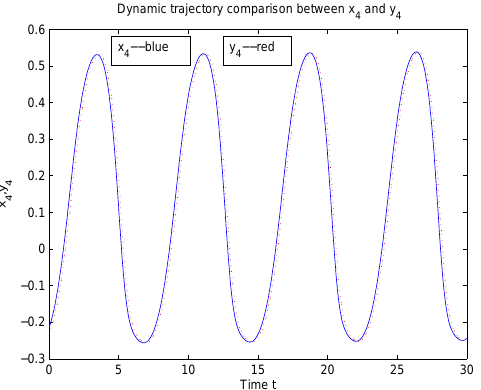
Figure 11. Computer simulations of synchronization between x 4 and y 4 for α =